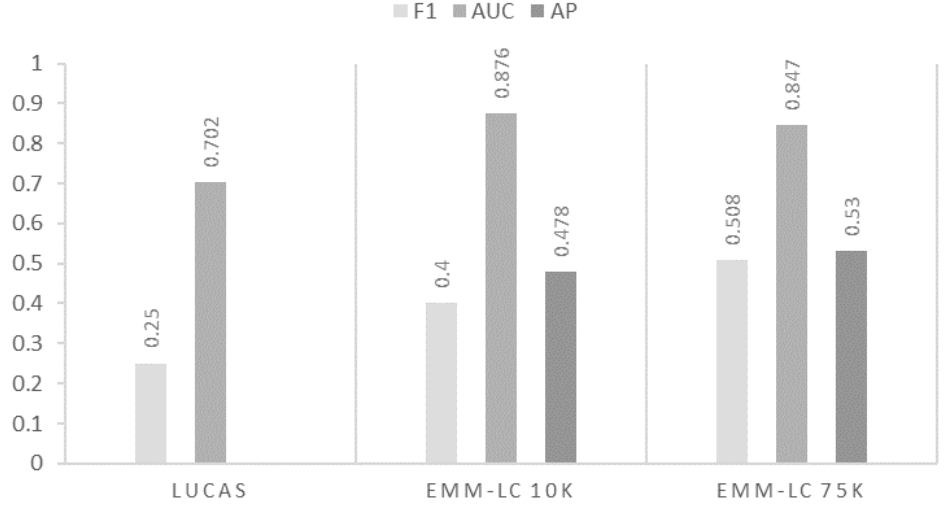
Figure 12. Varying degrees of CT feature enhancement.